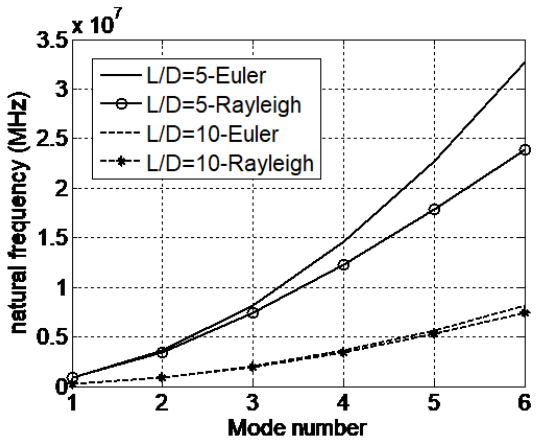
Figure 6: Variation of the first four natural frequencies with respect to length scale parameter-to-diameter ratio based on Bernoulli- Euler beam model for L = 6 D